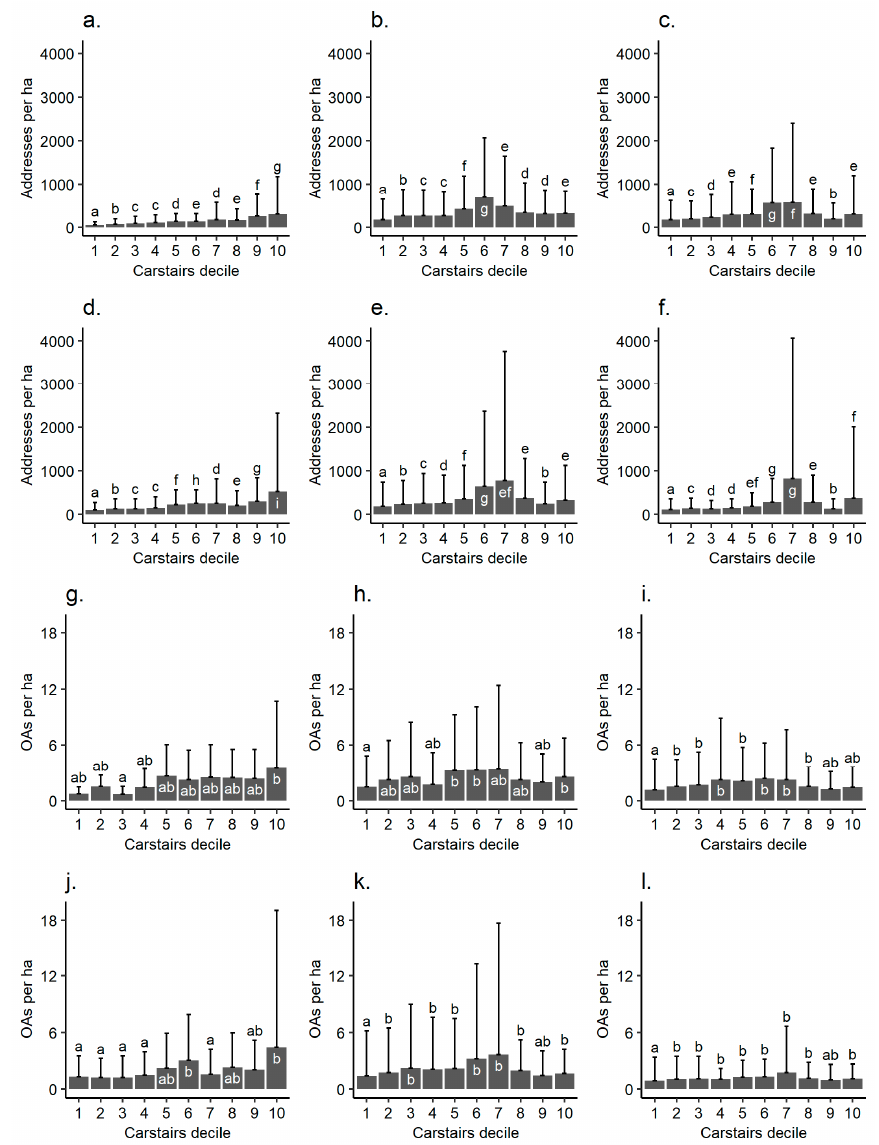
Figure 6. Variation in greenspace population pressure by decile of Carstairs Deprivation Index, for areas with access to at least one greenspace. Population pressure quantified at household scale by network analysis at 100 m (a), 300 m (b) and 500m (c) and by straight-line buffer at 100 m (d), 300 m (e) and 500 m (f); and at Output Area scale by network analysis at 100 m (g), 300 m (h) and 500 m (i) and by straight-line buffer at 100 m (j), 300 m (k) and 500 m (l). Positive error bars show one standard deviation. Different letters indicate significant differences among deciles, e.g., ‘a’ indicates a decile that is significantly different to ‘b’ but not different to other deciles marked ‘a’; while a decile marked ‘ab’ is not significantly different to those marked either ‘a’ or ‘b’ (Tukey’s test at α = 0.05).